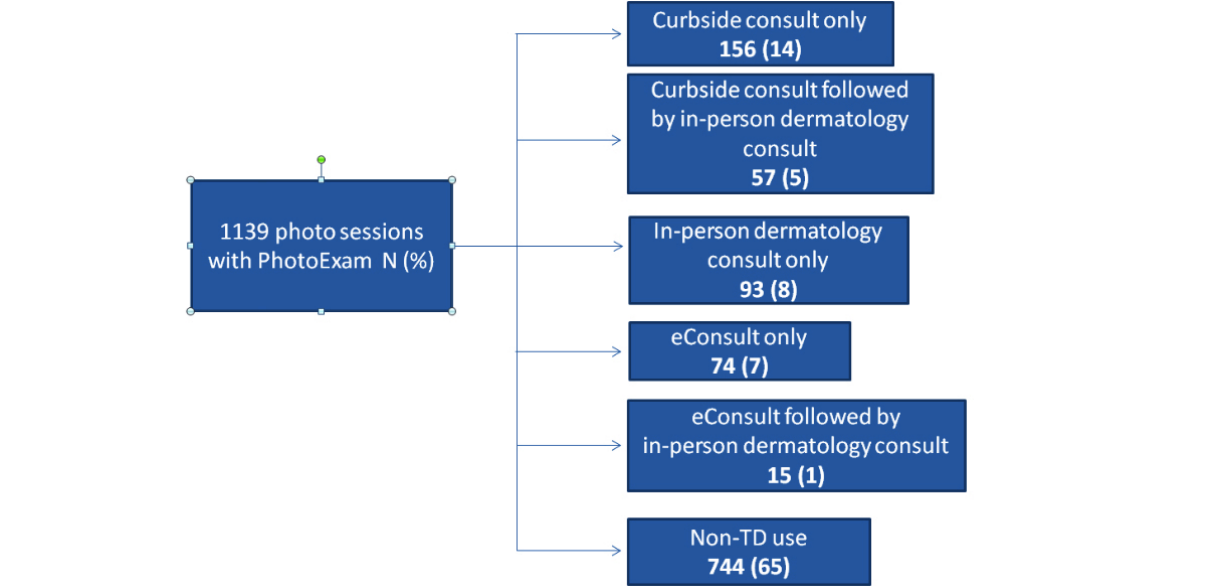
Figure 1. Flow chart of dermatology consultation rates and type of 1139 photo sessionsTD,